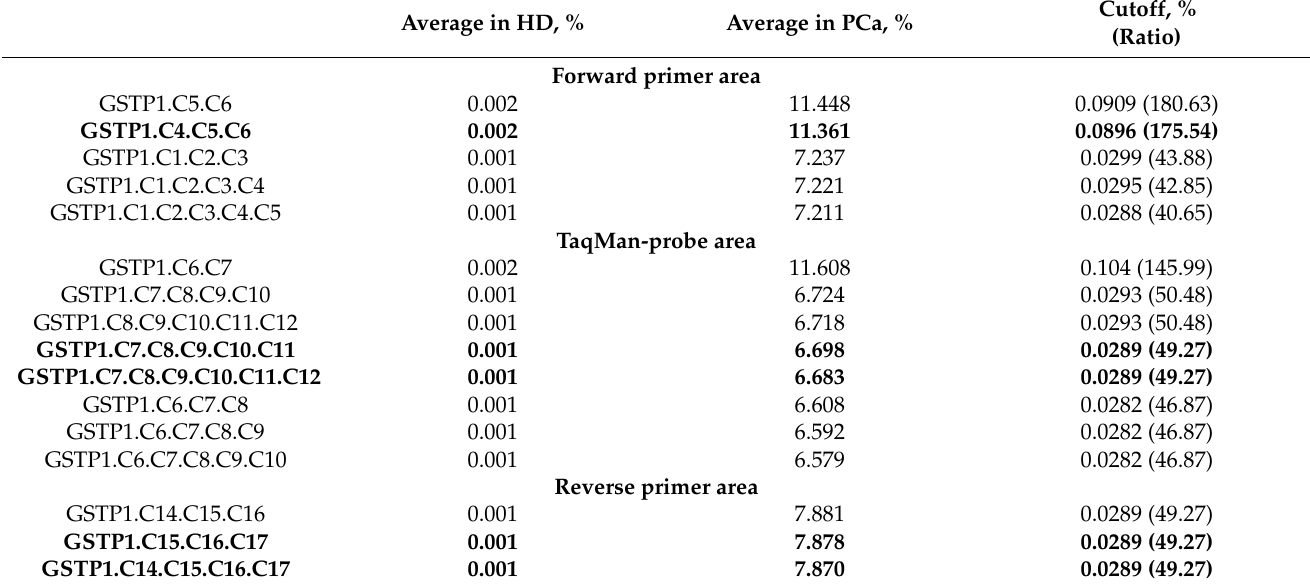
Table 6. Comparison of PCa patients with HD.